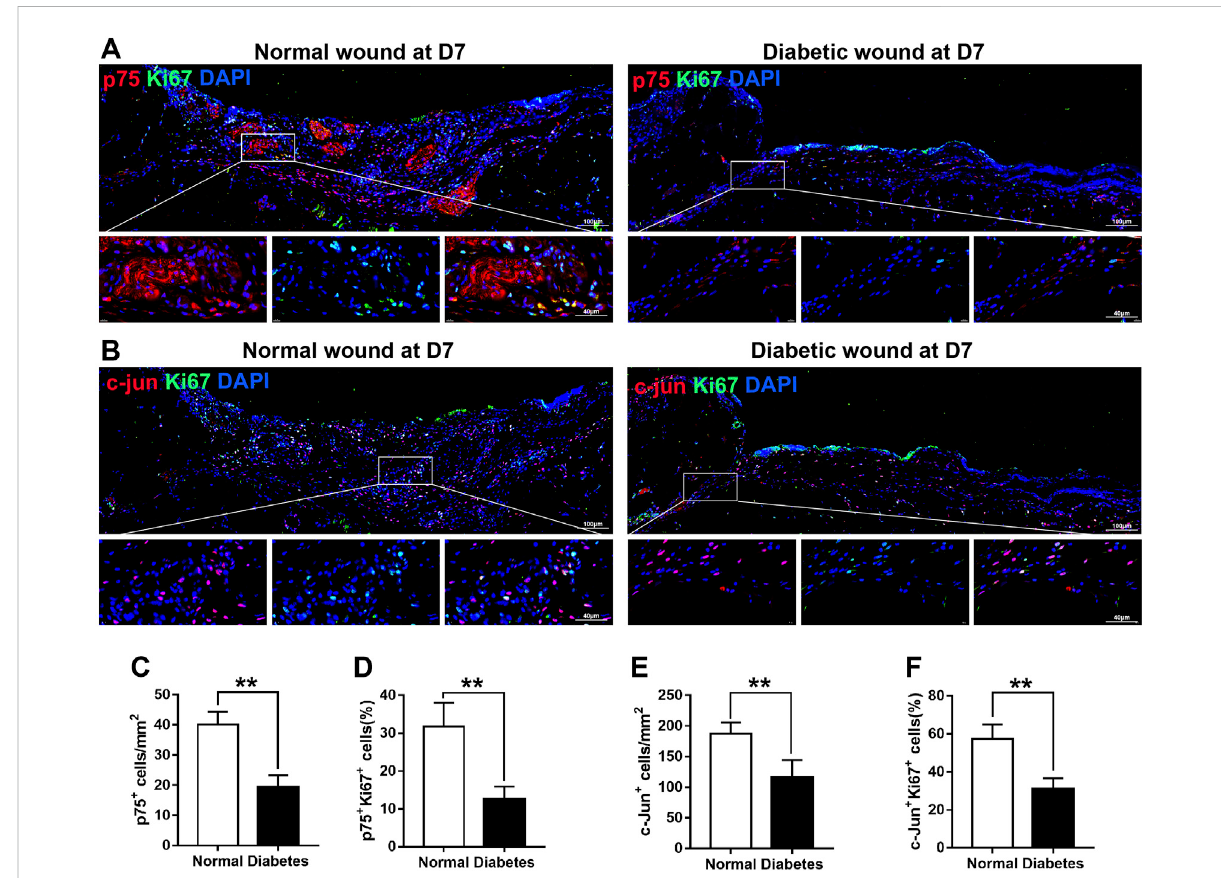
FIGURE 6 DiabeticwoundsdisplayreducedSCproliferation. (A) Representativeimmuno fl uorescenceanalysesofp75(red)andKi67(green)innormaland diabetic mice atday7post-wounding. (B) Representative immuno fl uorescence analysesofc-Jun (red) andKi67 (green) innormal anddiabetic mice at day 7 post-wounding. (C – F) The numbers or percentages of p75 + cells (C) , p75 + /Ki67 + cells (D) , c-Jun + cells (E) , and c-Jun + /Ki67 + cells (F) in normal and diabetic mice at day 7 post-wounding. Data are presented as mean ± SD, ** p < .01, n = 6/group, Student ’ s t